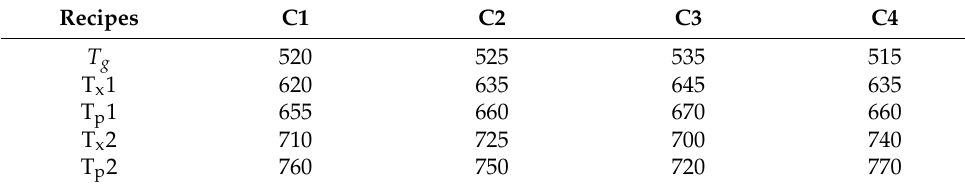
Figure 2. DSC curve of C1~C4 lithium aluminosilicate glasses and pictures of glass and glass-ce- ramics Table 2. DSC curves of the lithium aluminosilicate glasses ( ◦ Table 2. DSC curves of the lithium aluminosilicate glasses (°C).